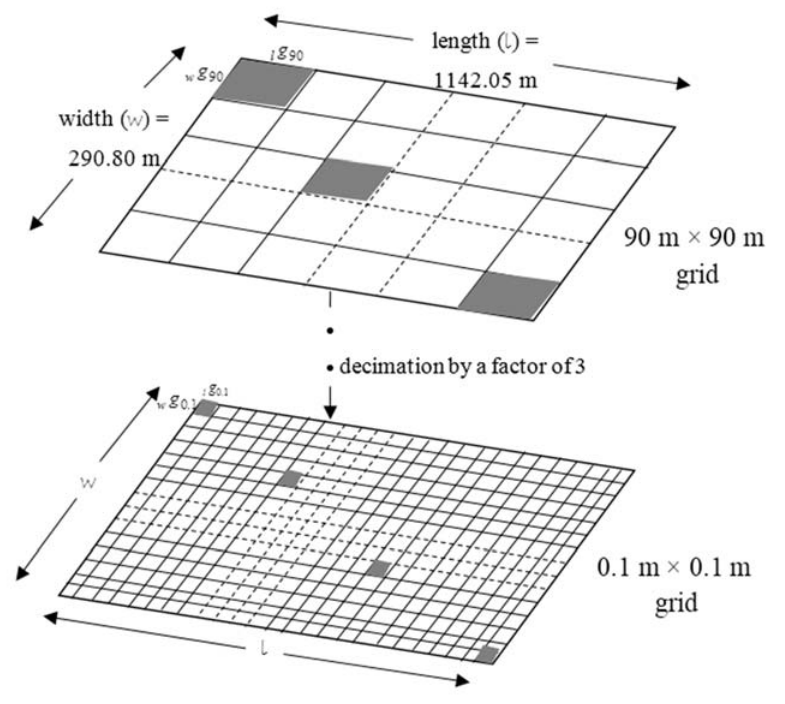
Figure 7. Grid based sampling approach for the RKT GPS point densification within the study area.